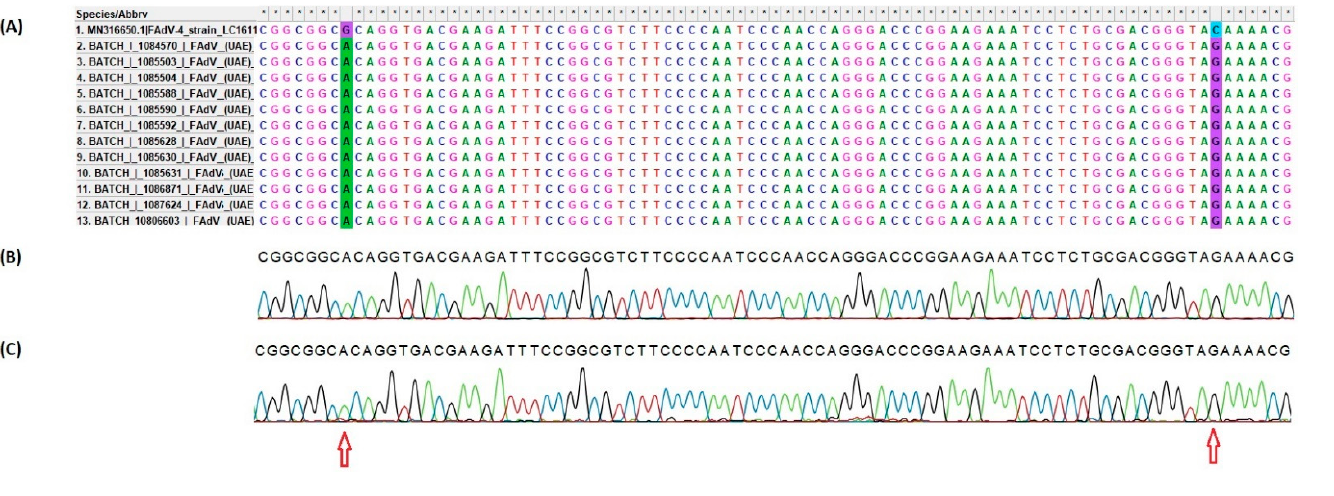
Figure 6. Mapping of the hexon gene sequence of FAdV of UAE field strains to the reference genome of FAdV serotype 4 strain LC1611 hexon gene (Sequence ID: MN316650.1) ( A ), while ( B ) and ( C ) represents the sequence and the chromatogram of two FAdVs hexon genes from UAE field strains, farm 1 and farm 2, respectively. The mutations G > A and C > G were highlighted in green and blue, respectively, while red arrows denoted their chromatogram. * denotes for 100%